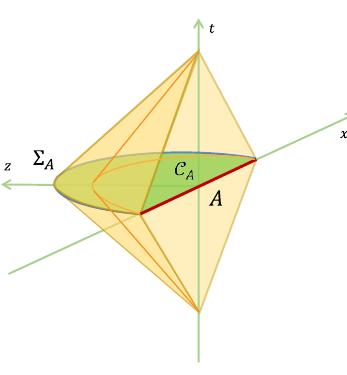
Figure 1 . An illustration for Causal Wedge C W ( A ) and Entanglement Wedge E W ( A )